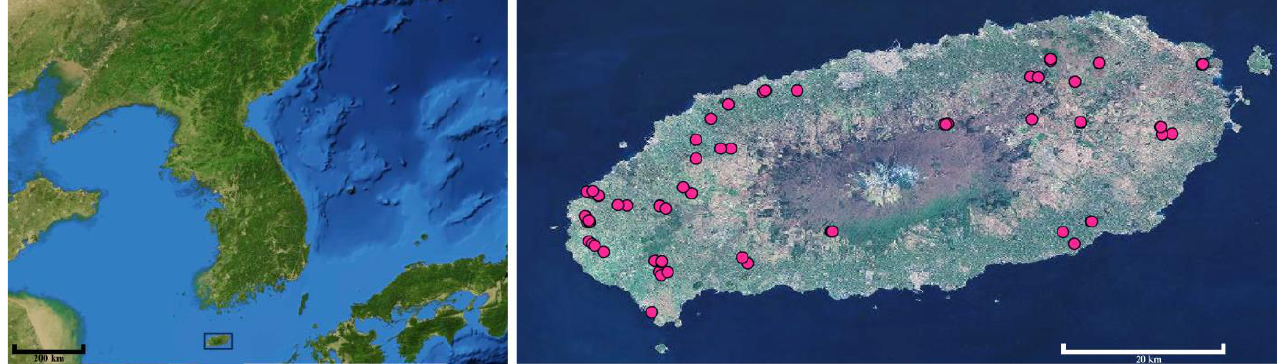
Figure 1. Geographic position of Jeju Island and its map with localities sampled here. Base map from Yandex Maps https://yandex.ru/maps/ (accessed on 1 October 2022).